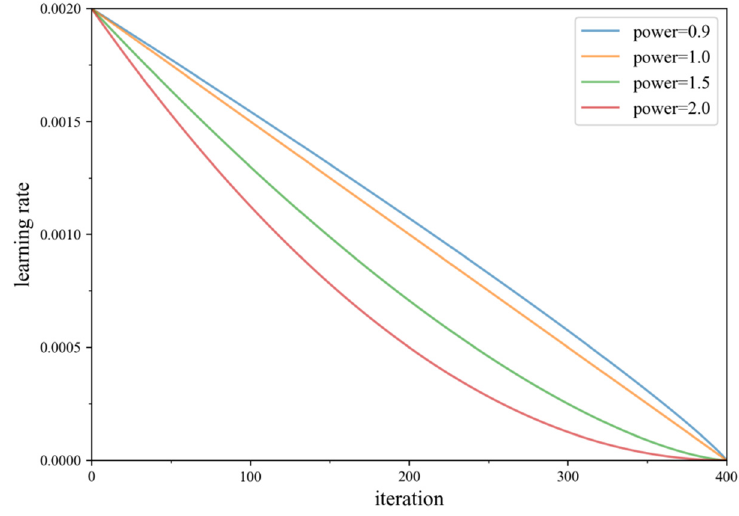
Figure 7. The decay curves under different power values.